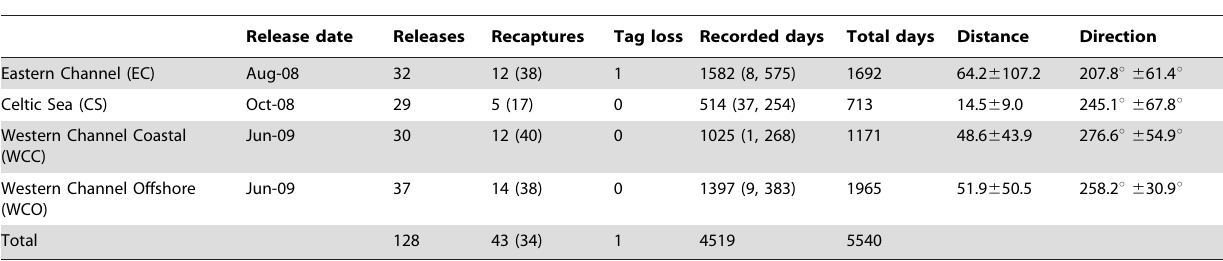
Table 1. Mark-recapture